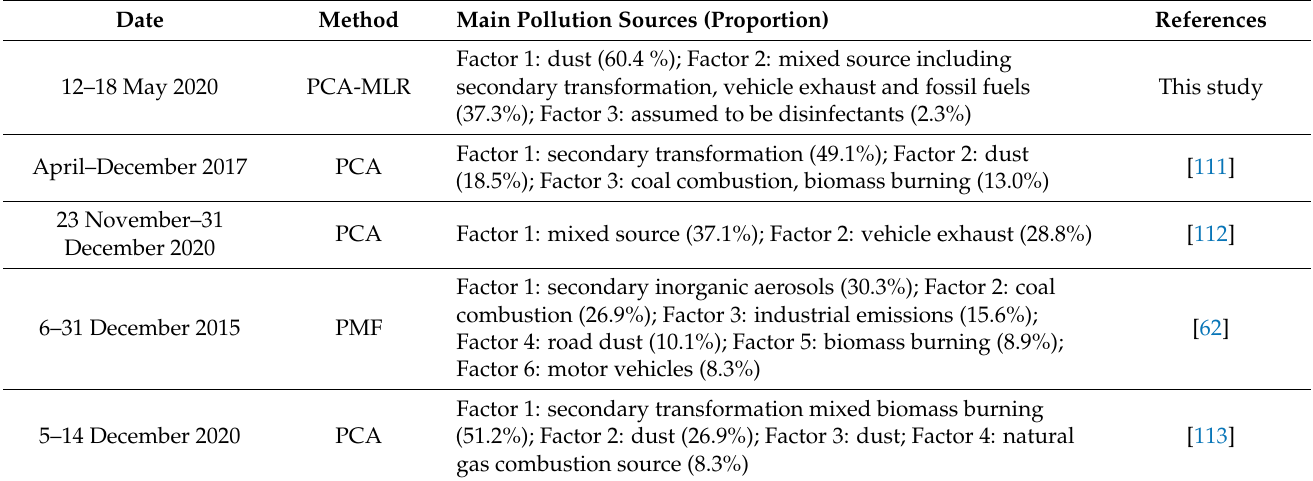
Table 4. Comparison with other studies on source